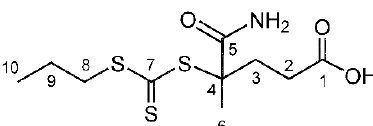
Figure 1. Chemical structure of 5-amino-4-methyl-4-(propylthiocarbonothioylthio)-5-oxopentanoic acid (APP) used as chain transfer agent (CTA) for reversible addition-fragmentation chain-transfer polymerization (RAFT) polymerization and its numeric assignments for 1 H and 13 C-NMR spectra.